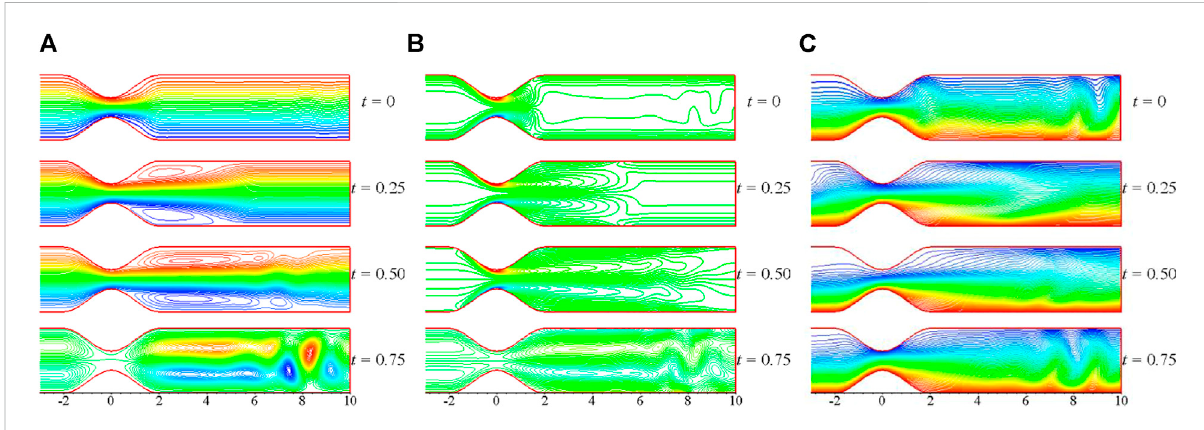
FIGURE 22 (A) Streamlines, (B) vorticity, and (C) temperature distribution plots at the four instants of a pulse cycle with Re (cid:2) 700 , M (cid:2) 5 , St (cid:2) 0 . 02 , Pr (cid:2) 1 , and Rd (cid:2) 0 . 2 for Cu - H 2 O